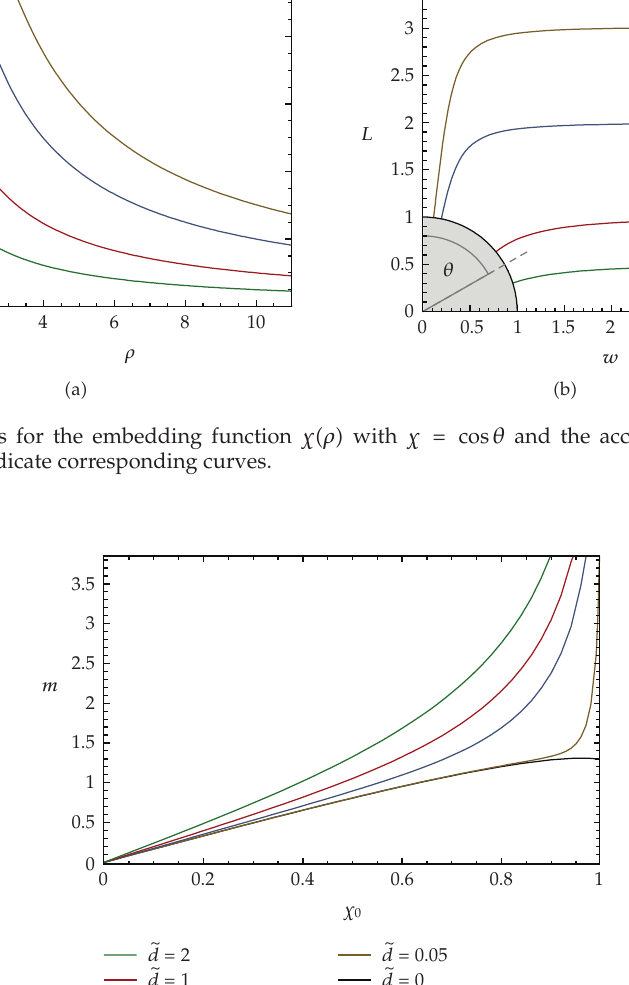
we do not discuss here. (cid:2) The trained eye can see that there is a maximum of m (cid:5) 1 . 3 in Figure 7 before m drops to smaller values towards χ 0 (cid:5) 1. This is reflecting the existence of a (cid:11) phase transition to Minkowski embeddings at d (cid:5) 0 (cid:3)